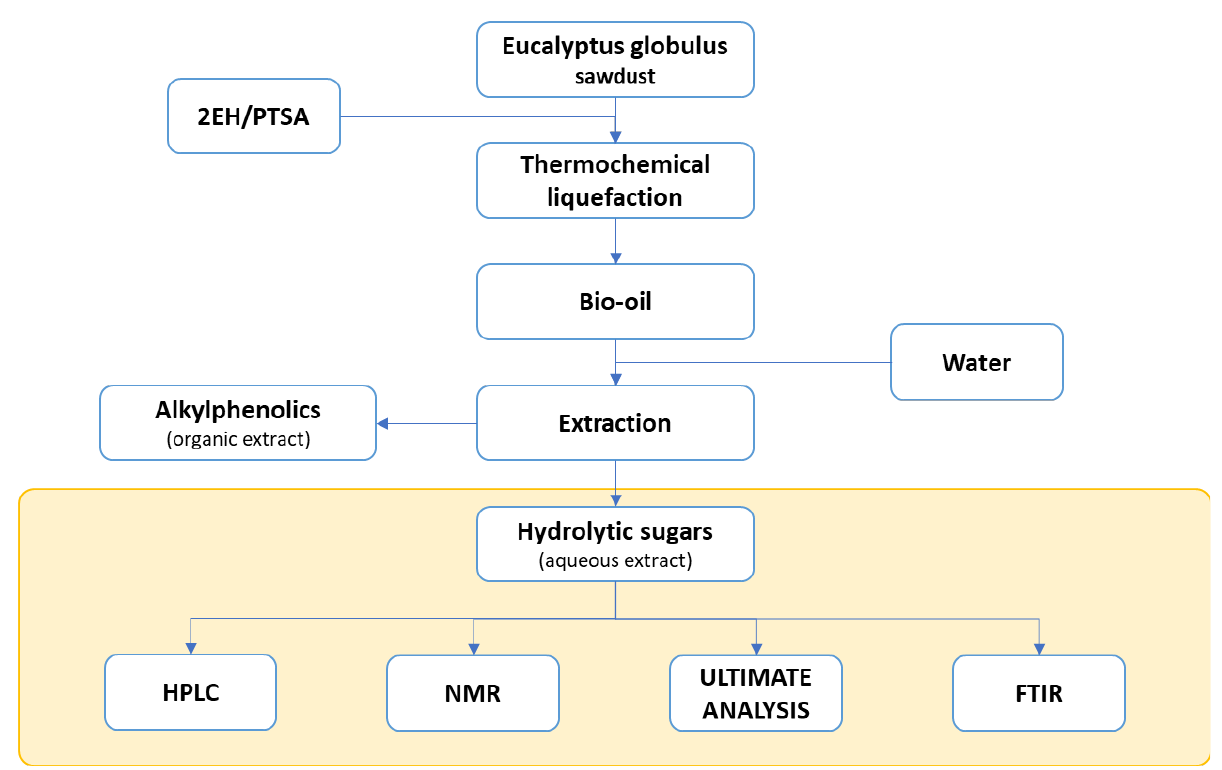
Figure 1. Flowchart followed in characterisation of aqueous extract.